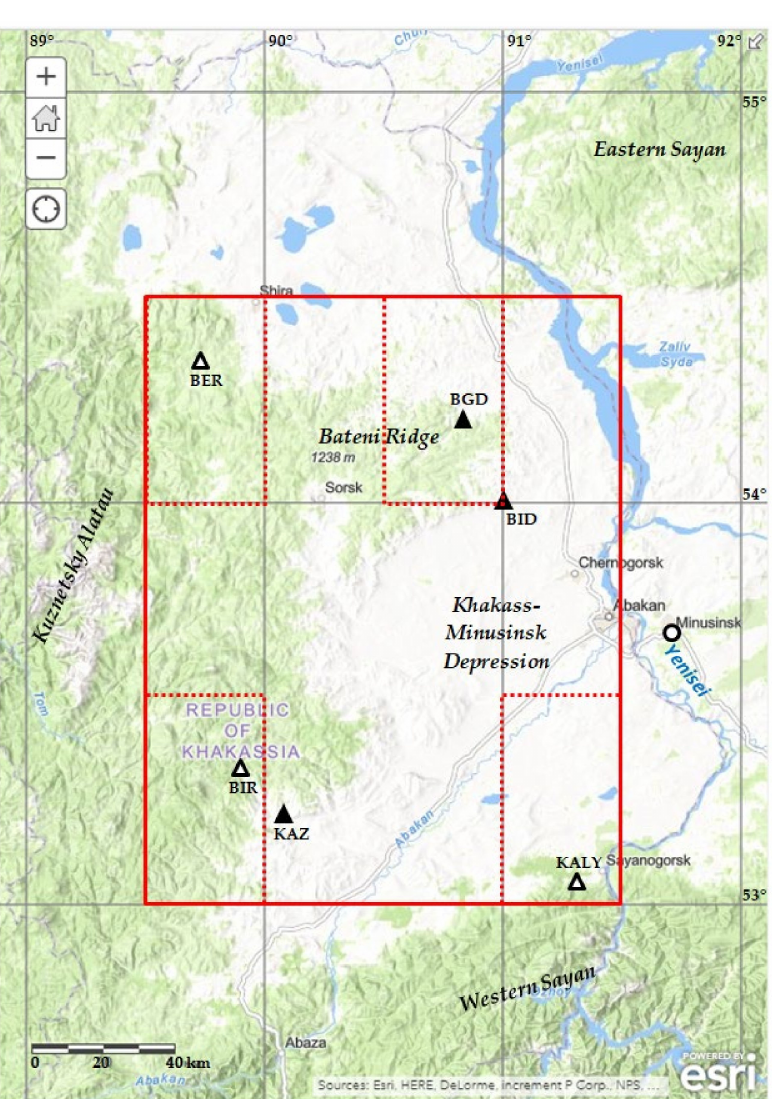
Figure 1. The study area. Black solid triangles depict sampling sites in the forest-steppe zones, open triangles depict sub-taiga zones, and the open circle depicts the Minusinsk weather station. The area within the large rectangle outlined by the solid red line was used for the regional average in the grid SPEI series, and areas in the smaller rectangles outlined by dotted red lines are grid cells used to assess the climate in the sampling sites. The background map image was generated using the ArcGIS online map tool [51]; it is the intellectual property of Esri and is used herein under license (© 2020 Esri and its licensors; all rights